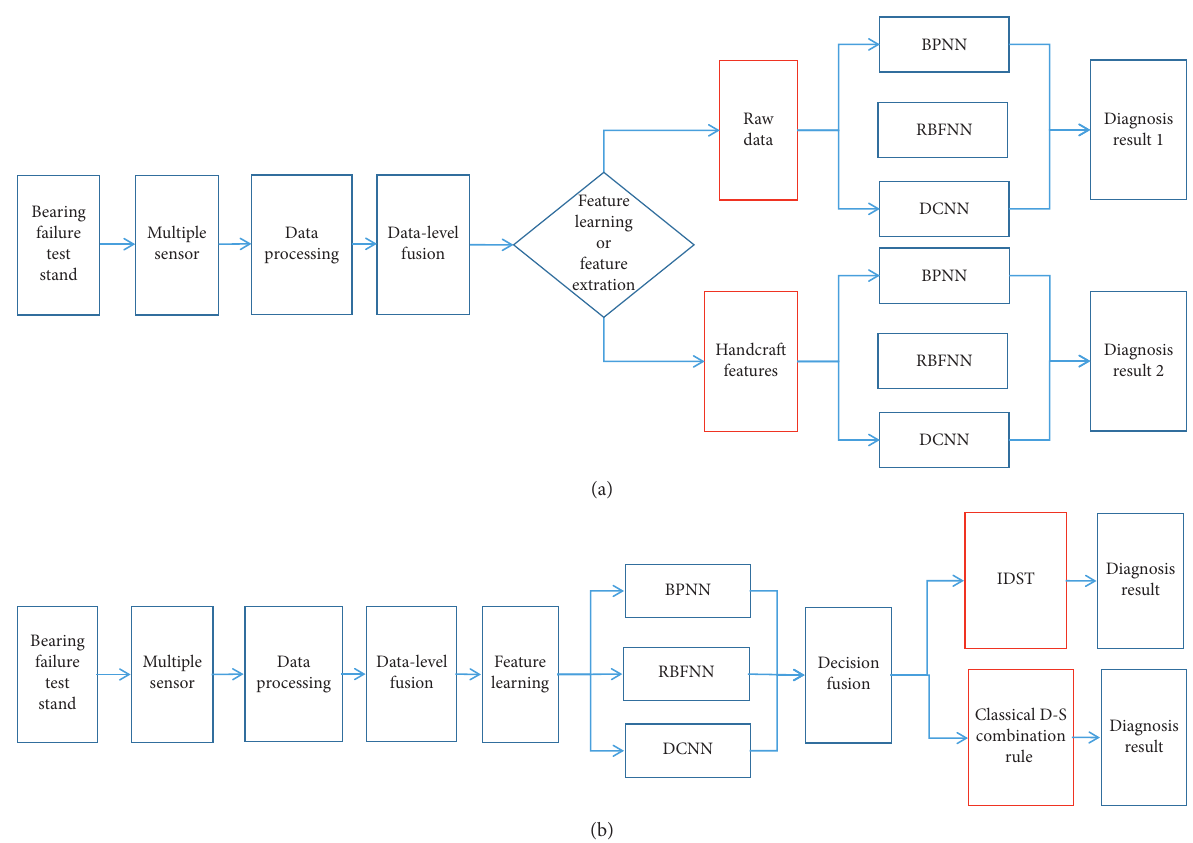
Figure 3: Flowcharts of comparative methods. (a) Advantages of artificial feature extraction and DCNN adaptive feature extraction. (b) The diagnosis effect of the new approach based on IDSET and D-S synthesis formula is verified.